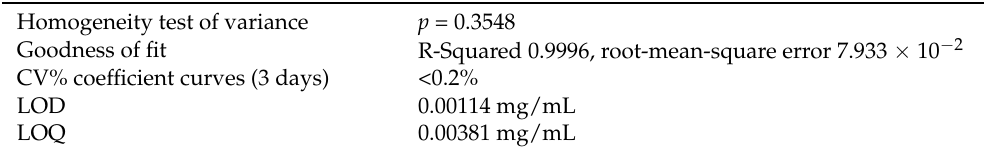
Table 7. Method validation